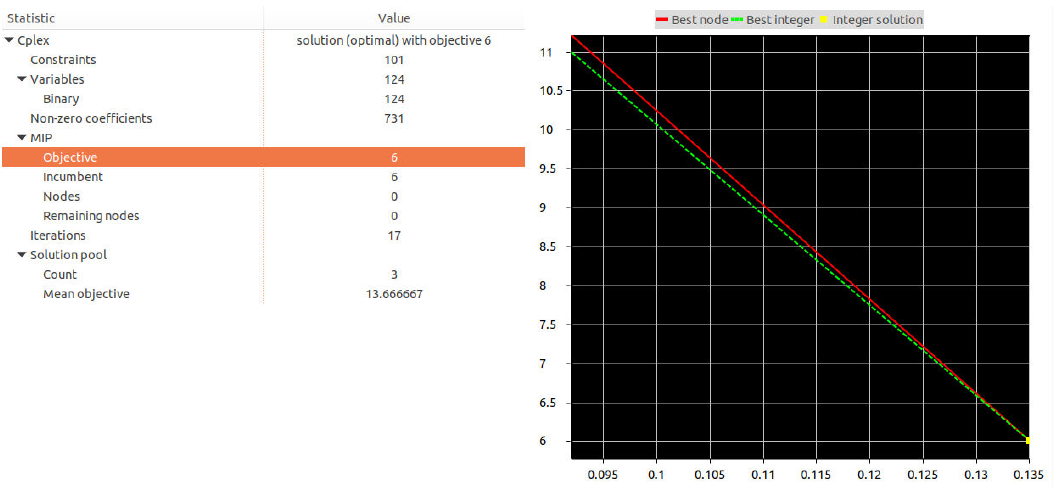
Figure 14. Cplex solution: